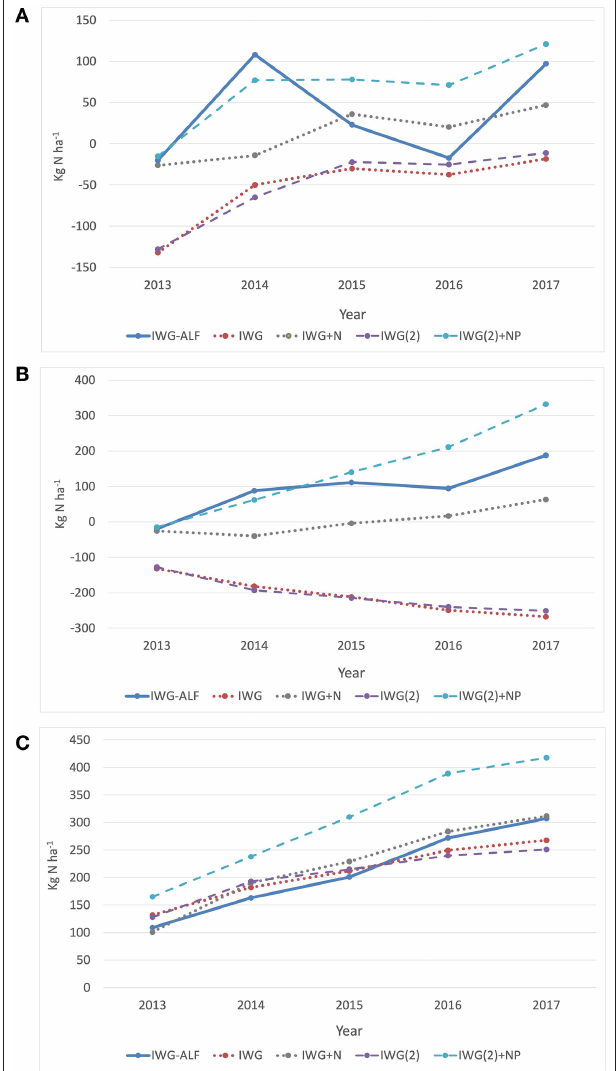
FIGURE 4 | N balance comparisons of intercropped IWG-ALF with unfertilized and fertilized IWG treatments. (A) Yearly N balance calculated as managed N inputs in urea or alfalfa N fixation minus N exported in harvest, (B) Cumulative N balance over 5 years, (C) Cumulative N export in grain + biomass harvests over 5